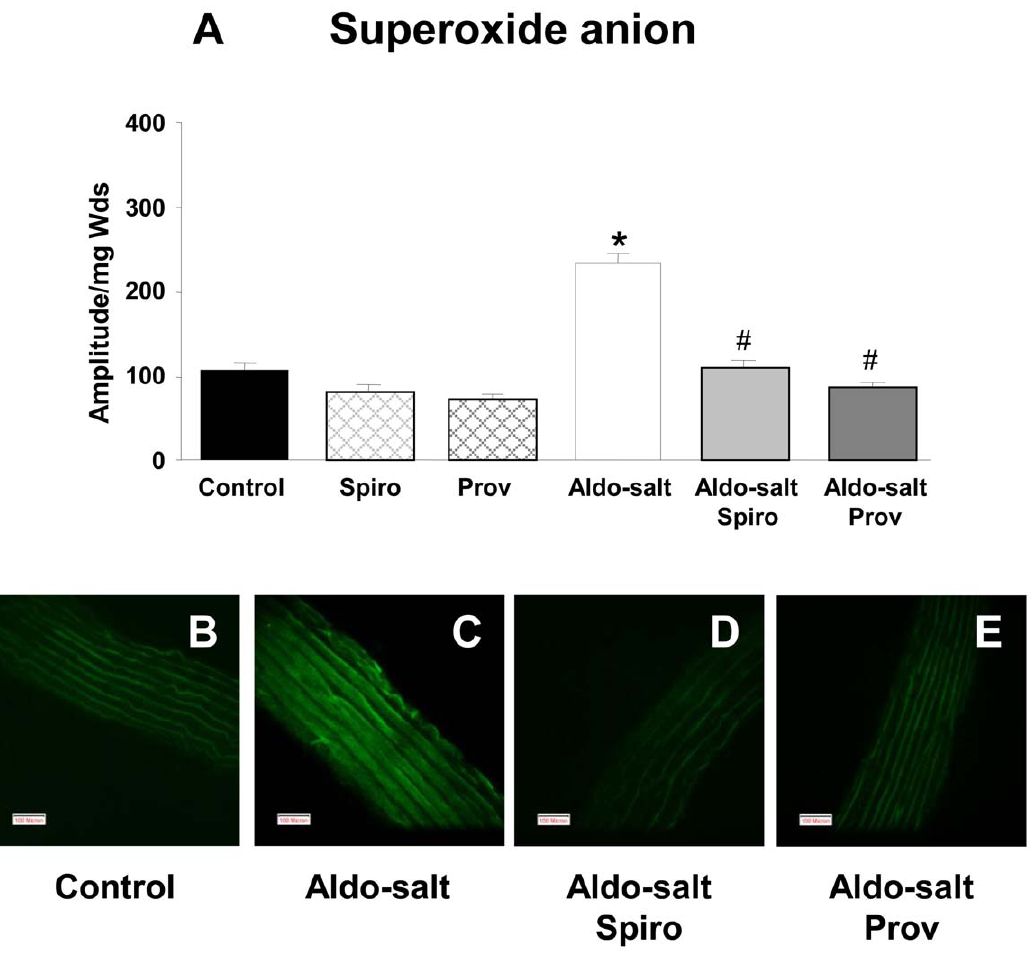
Figure 4. Superoxide anion and nitrotyrosine staining in aorta. Quantification of the amplitude of O 2– CMH signal (A) and immunohistochemical staining for nitrotyrosine (B-E) in aortae (n=4–5 for each group). Values are means 6 SEM, * P , 0.05 vs control rats, # P , 0.05 vs Aldo-salt rats.